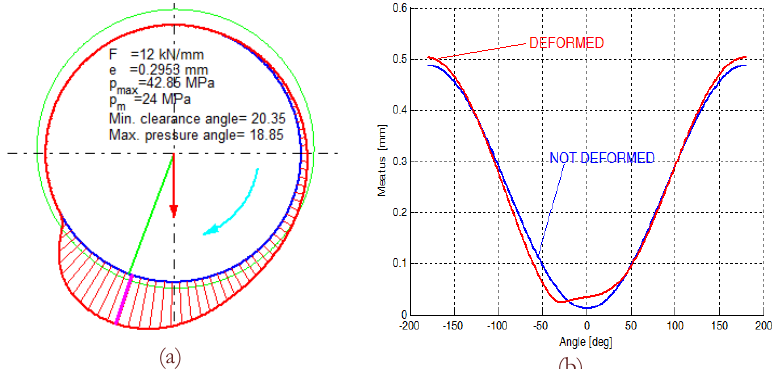
Figure 6: (a) Pressure distribution for JB1 configuration ( α =0, T in =40°C – T out =80 °C) with deformable components; (b) lubrication meatus for rigid and deformable